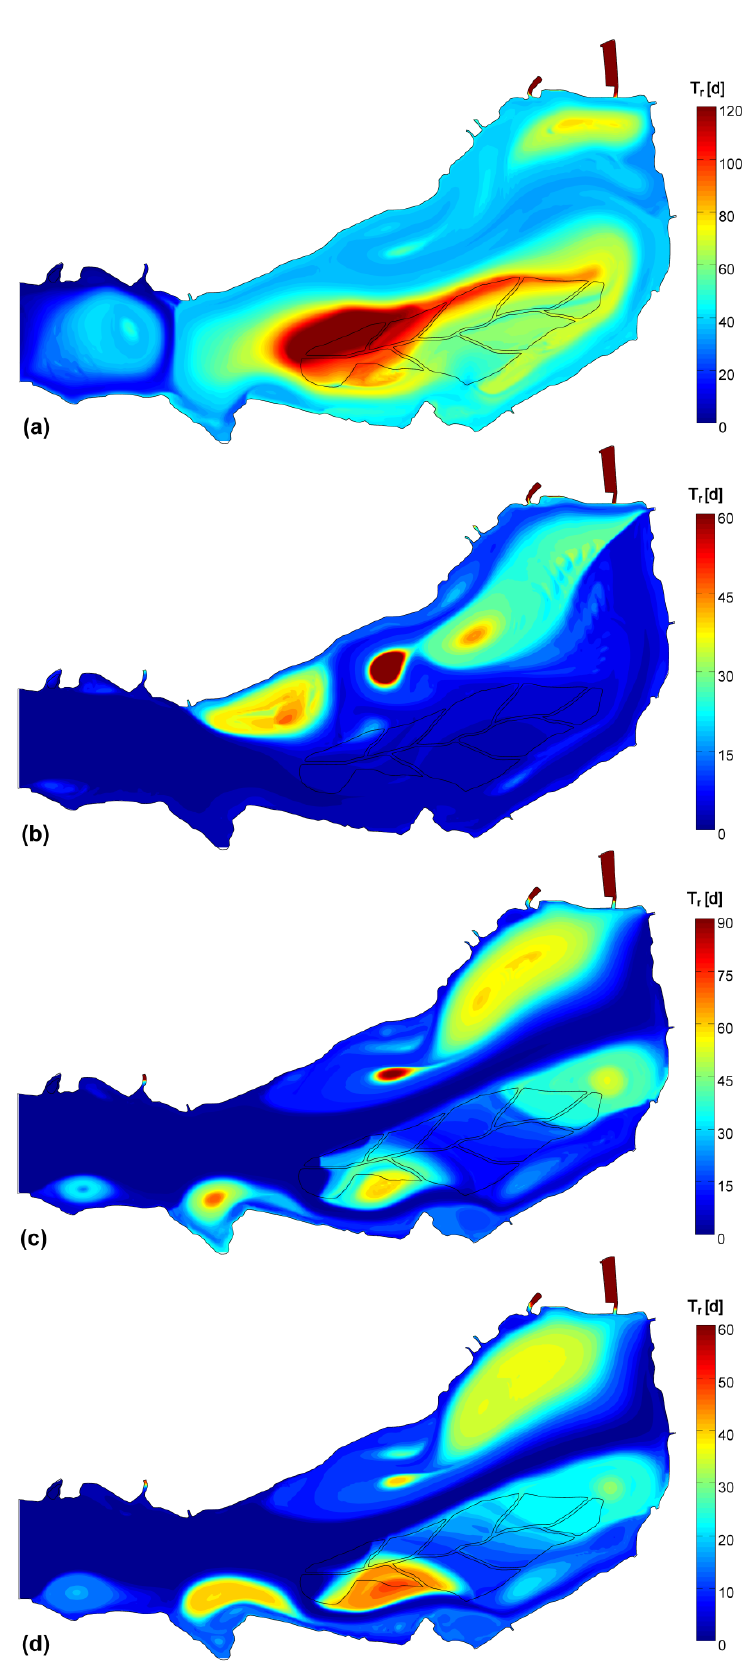
Figure 6. Surface 1 m local water renewal times for the MIVIS 26 July 2007 ( a ); CHRIS-PROBA 29 June 2008 ( b ); CHRIS-PROBA 28 August 2011 ( c ) and APEX 21 September 2011 ( d )